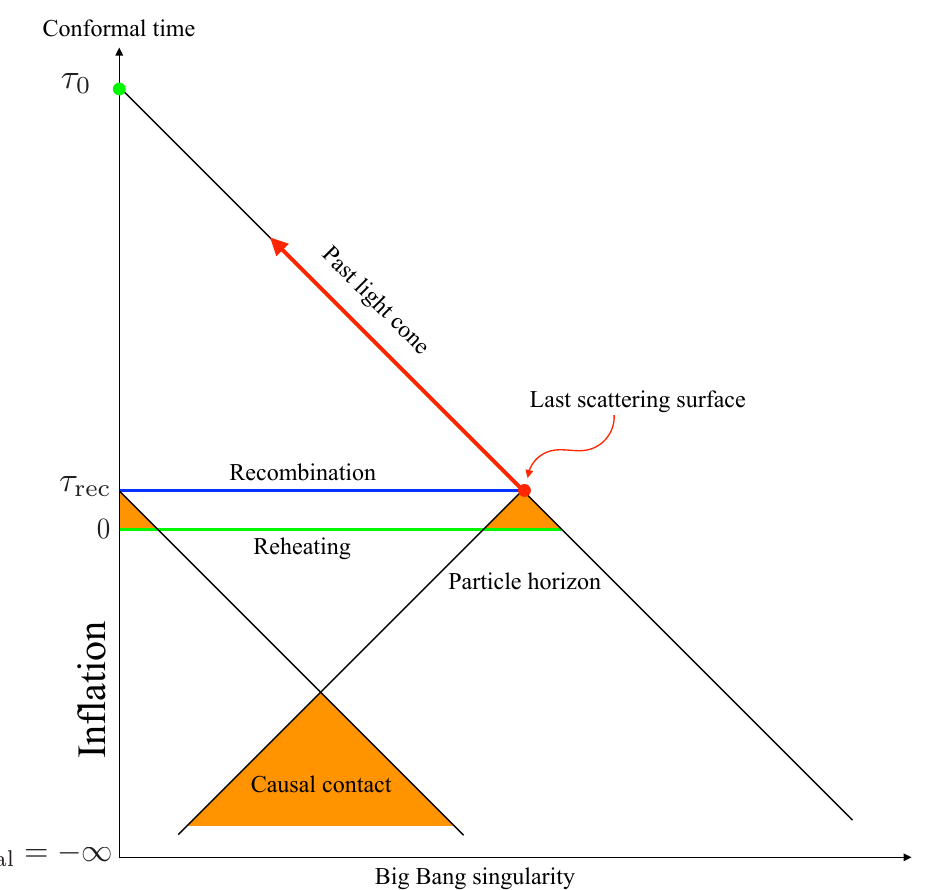
Figure 3. How inflation solves the horizon problem. The light cones on the causal diagram of an inflationary FLRW model are at 45 ◦ . The worldlines of comoving matter are vertical on this kind of ± diagram. The particle horizons are horizontal lines. Here we have shown the particle horizon for the CMB. Without inflation, conformal time would only go back to τ 0 , and different regions of the CMB which we observe today along our past light cone would never have been in causal contact. Because of inflation, conformal time is extended to the Big Bang singularity, so these regions would have been in causal contact at some point in our past light